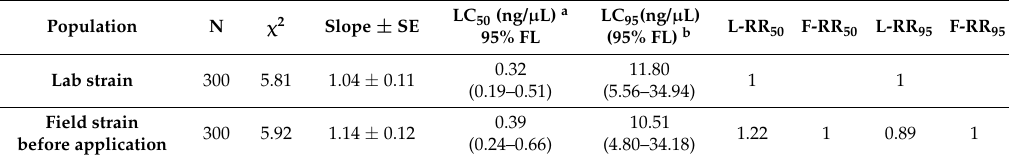
Table 7. Susceptibility of Diaphorina citri adults exposed to dimethoate from field plots under different treatment